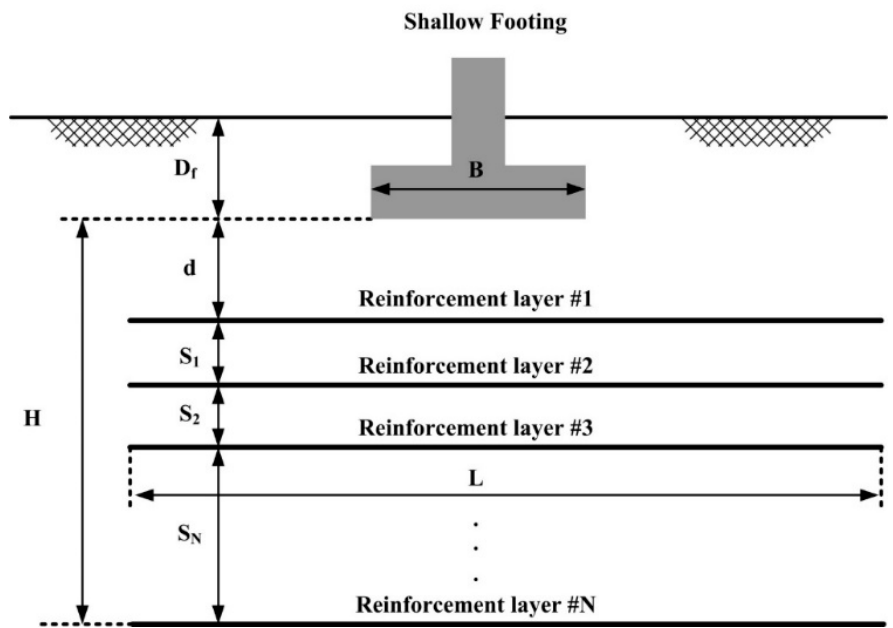
Figure 2. Typical geotextile-reinforced soil system.